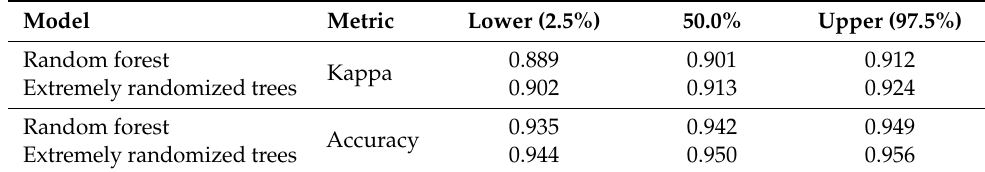
Figure 12. Distribution of kappa and overall accuracy of the ML models obtained from a bootstrap sampling of the test. Table 8. 95% confidence intervals of the overall performance metrics of the ML